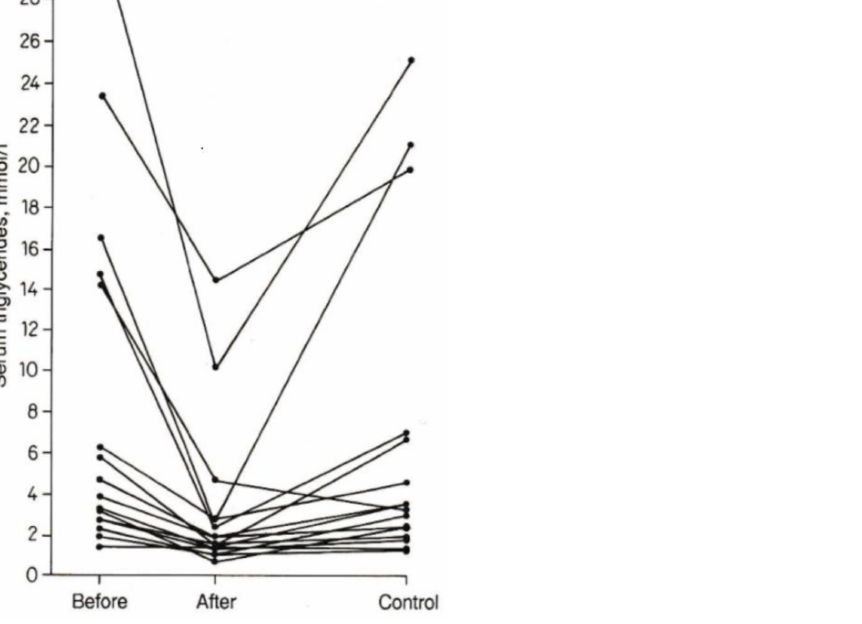
Figure 1. Serum TG of individual patients with HLP types IIa, IV and V before and two weeks after an isocaloric diet including canned mackerel (2 cans/day over 2 weeks), control 3 months later on habitual diet; modified after